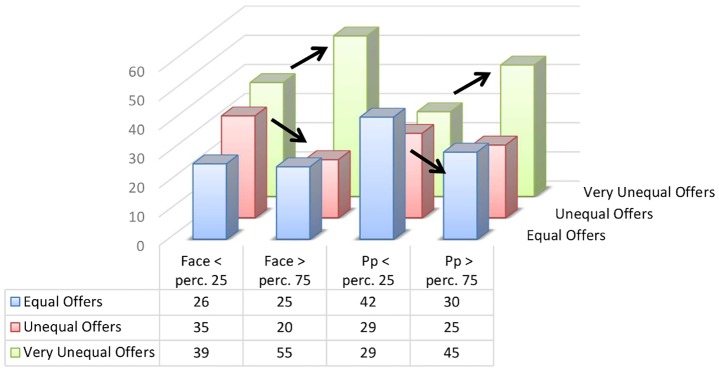
Distribution of offers on the extremes of participants’ and face’s Benevolent Sexism.Percentage of equal, unequal, and very unequal offers made by participants below the 25th percentile and above the 75th percentile in endorsement of benevolence and the same percentages for faces whose perceived sexist benevolence was below the 25th percentile and above the 75th percentile (based on raw data, Study 1).